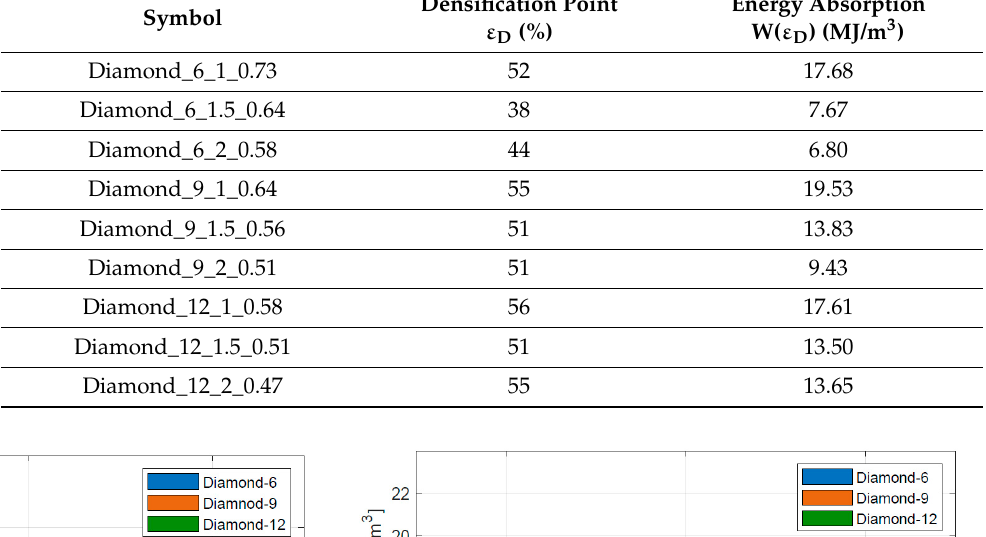
Table 5. Basic energy absorption parameters of tested Diamond TPMS cylindrical structures.